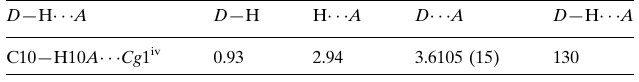
Hydrogen-bond geometry (A˚ , (cid:2) ). Cg 1 is the centroid of the N1/N3/C1–C3